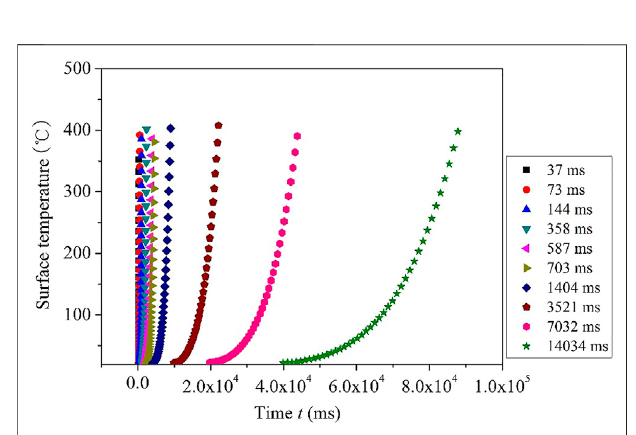
FIGURE 5 | The average surface temperature of the twisted plate at various heat generation